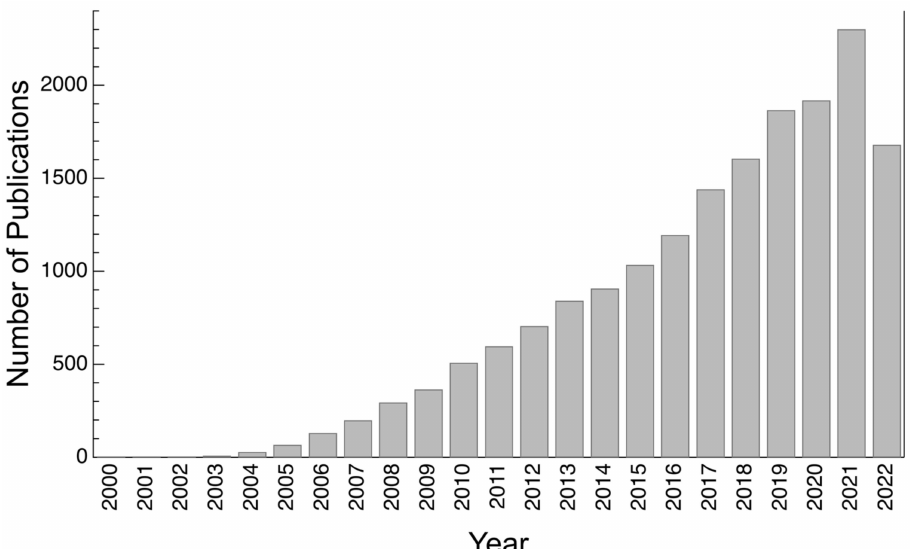
Figure 2. Plot showing the rising number of publications indicative of an increasing interest in the area of superhydrophobicity. A keyword search of “superhydrophobic” was performed using the Web of Science search engine. Meeting abstracts and proceedings papers were excluded from the search.